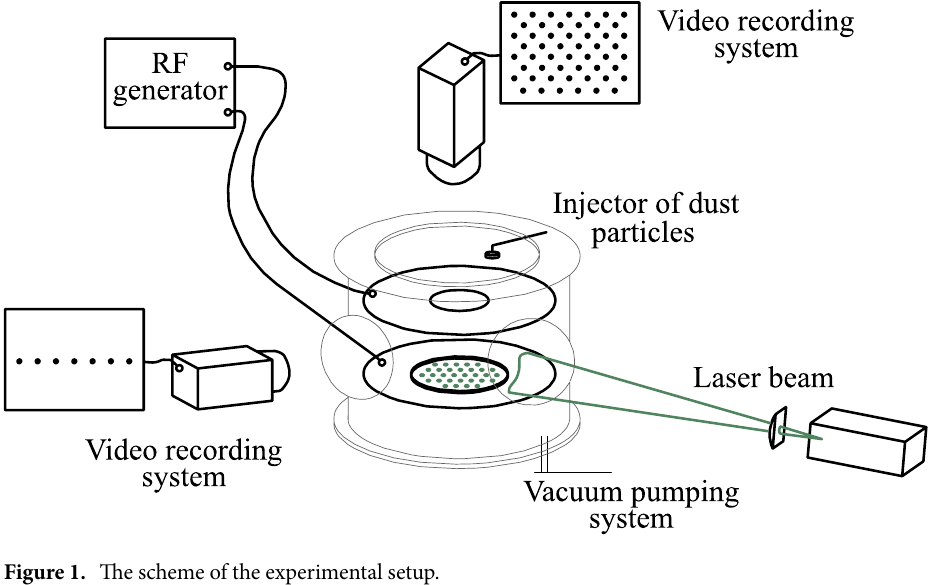
Figure 1. The scheme of the experimental